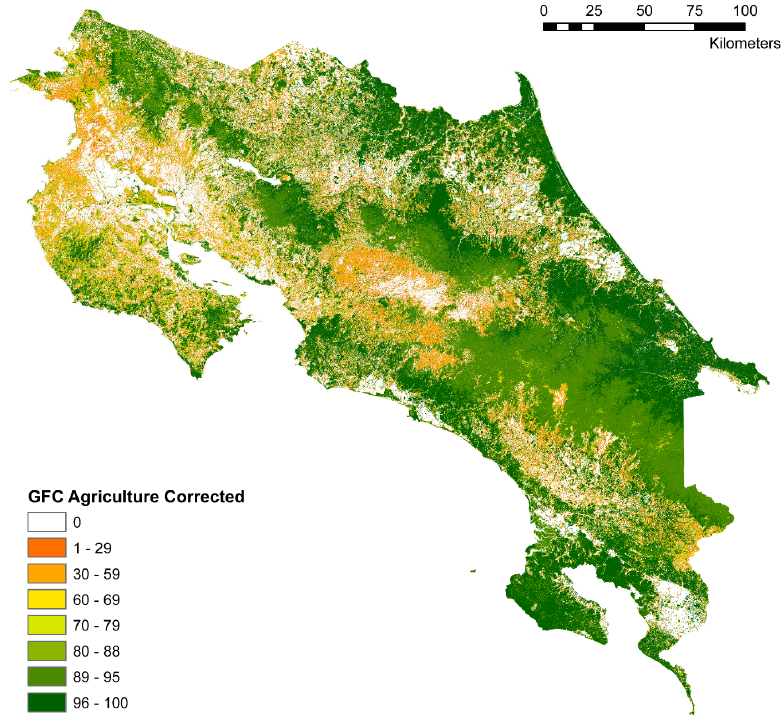
Figure A8. Partly corrected GFC estimated tree cover across Costa Rica (2015) displayed to emphasize bias patterns. This map has been corrected for agricultural errors but not precipitation and elevation. Note the absence of tree cover in the coastal and central agricultural regions as well as remaining differences in estimated tree cover between the east and west of the country. Remote Sens. 2020 , 12 , 3226 31 of 37